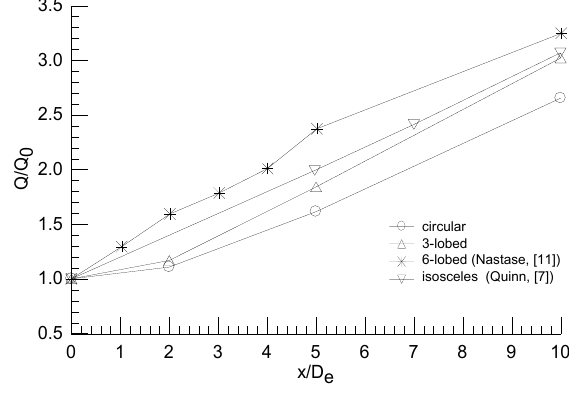
Fig. 8. Streamwise velocity decay along the jet centerline